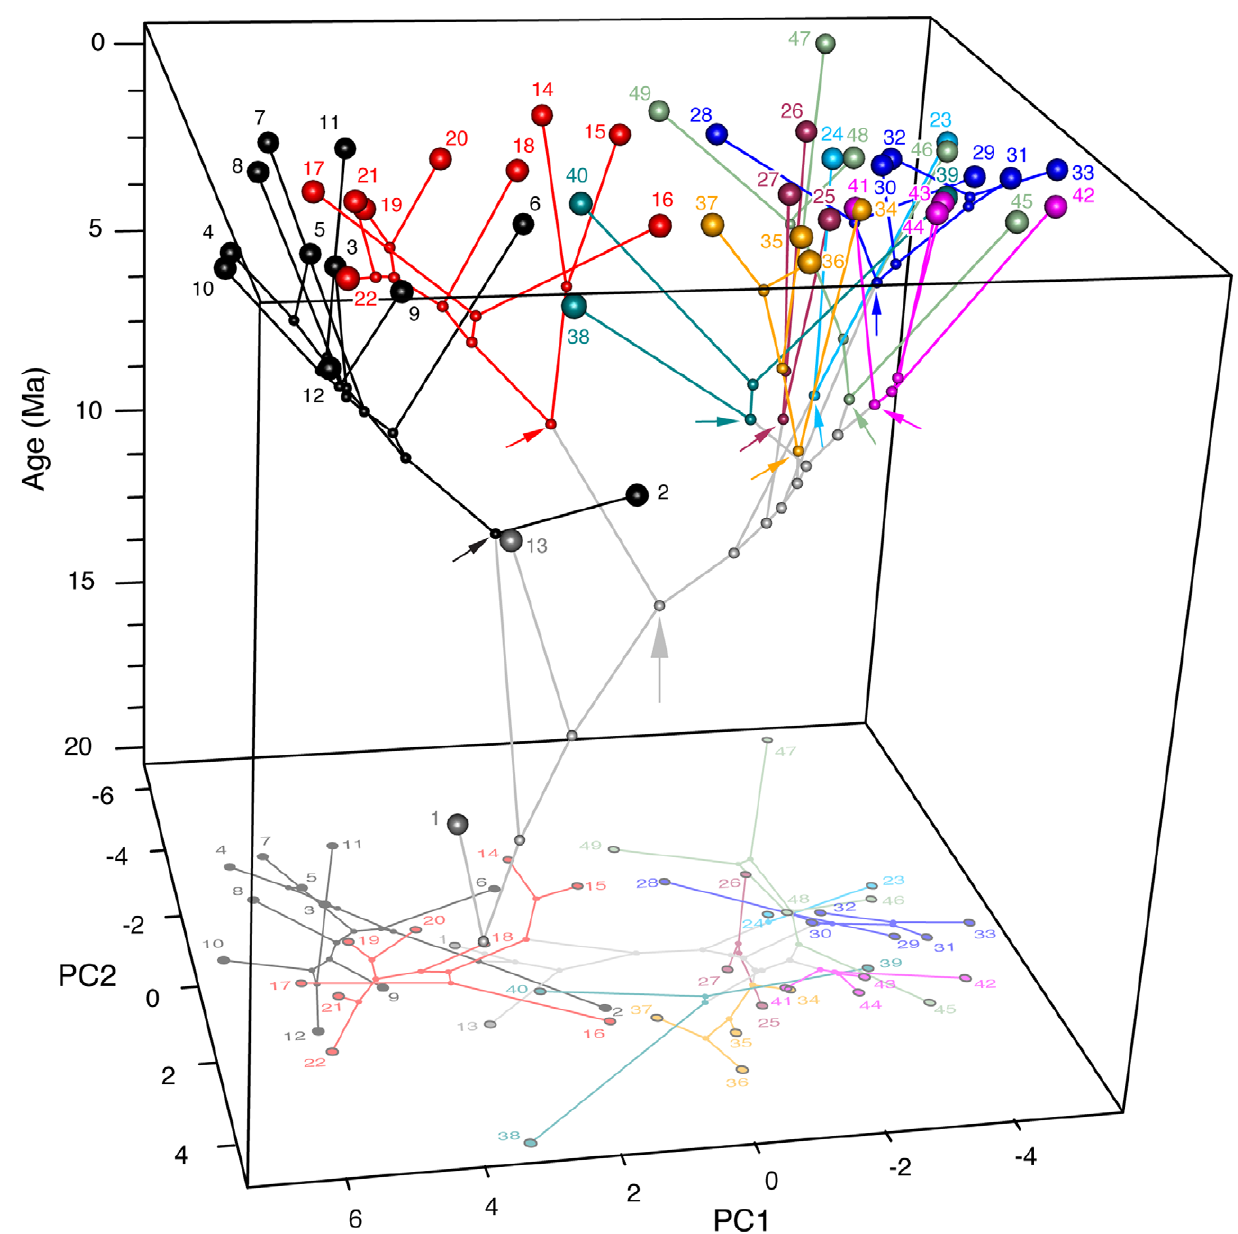
Figure 6. Chronophylomorphospace of Felidae. The transition of two-dimensional morphospace occupation through time can be visualised as a chronophylomorphospace plot. Positions in morphospace of ancestors were estimated using maximum likelihood and a composite phylogeny of Felidae with scaled branch lengths (Fig. 2). Two-dimensional coordinates of ancestors and terminals were then plotted against time as the third axis. Color-coded arrows point to the latest common ancestor of each lineage. The grey arrow points to the last common ancestor of Felinae. The drop- down shadow shows a planar projection of the chronophylomorphospace on the two-dimensional morphospace area delimited by the PC1 and PC2 axes. Numbers and colors are as in Fig. 2.